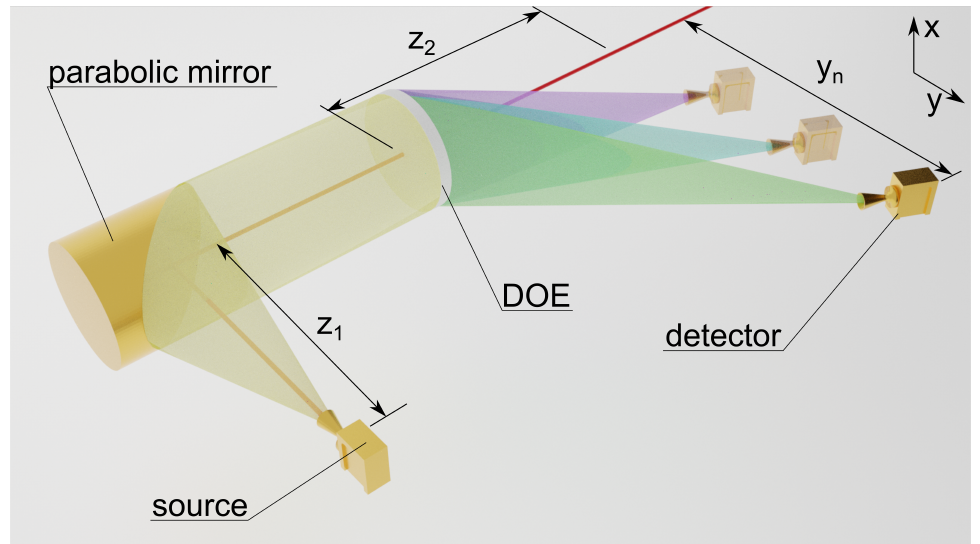
Figure 5. Image depicting experimental setup. z 1 was equal to 600 mm, z 2 was established as optimal distance for 300 GHz for f = 200 mm and f = 400 mm separately. Distance of the scan in the measurement plane from optical axis y n depended on frequency of reconstruction (details in Table